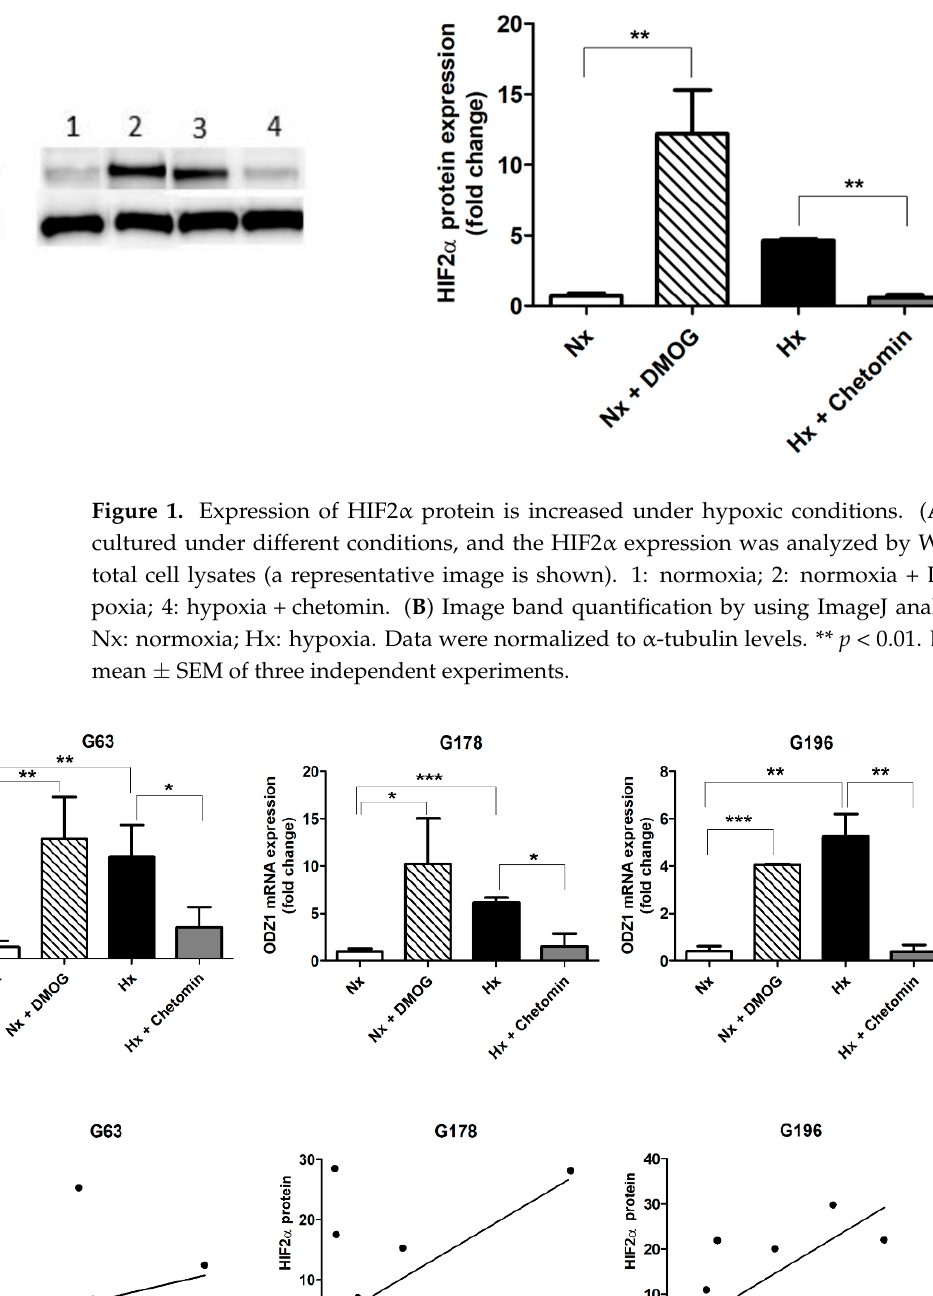
Figure 2. GSCs expressed ODZ1 in response to hypoxia and HIF regulators. ( A ) GSC cell lines were cultured in normoxia (Nx, 21% O 2 ) or hypoxia (Hx, 1% O 2 ) and treated or not with 250 nM chetomin or 0.5 µ M DMOG. ODZ1 expression was analyzed by qPCR. Data were normalized to G6PD levels. * p < 0.05, ** p < 0.01, *** p < 0.001. Bars represent mean ± SEM of three independent experiments. ( B ) Correlation between ODZ1 mRNA and HIF2 α protein. Pearson’s coefficient (r); p < 0.001.